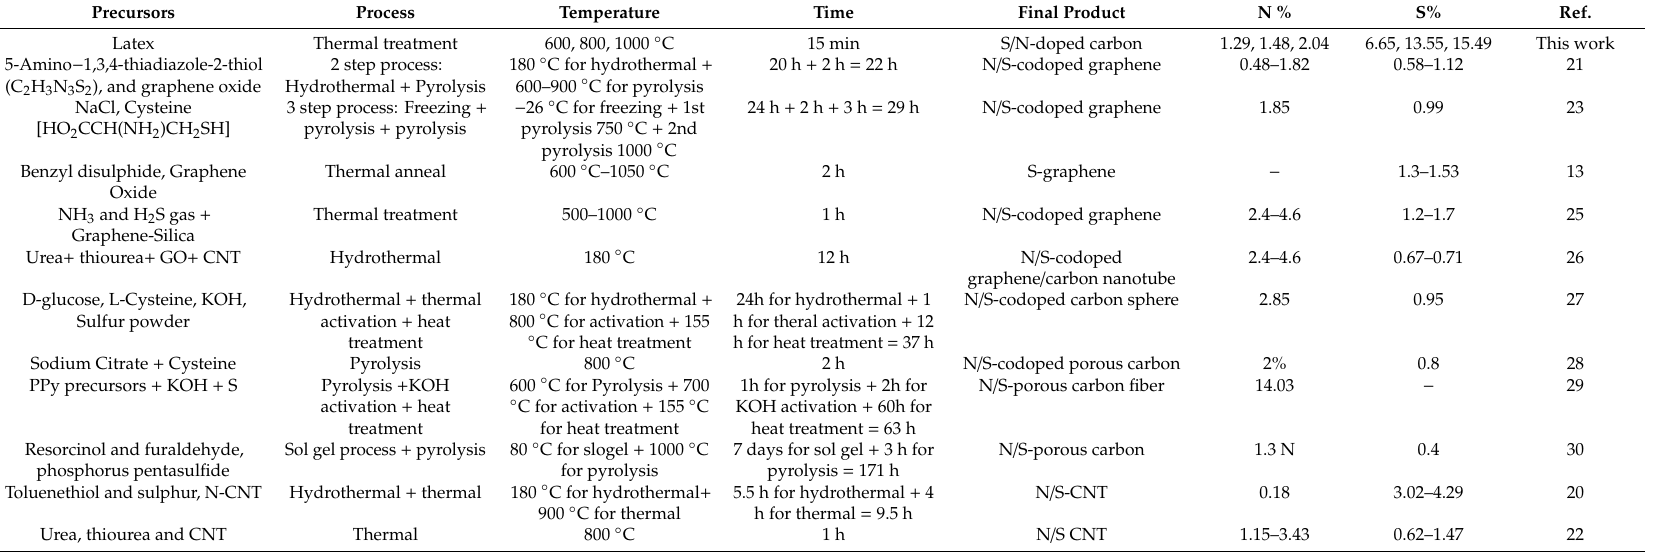
Table 3. Comparative Study with Reported Carbon Materials Based on S-Doping